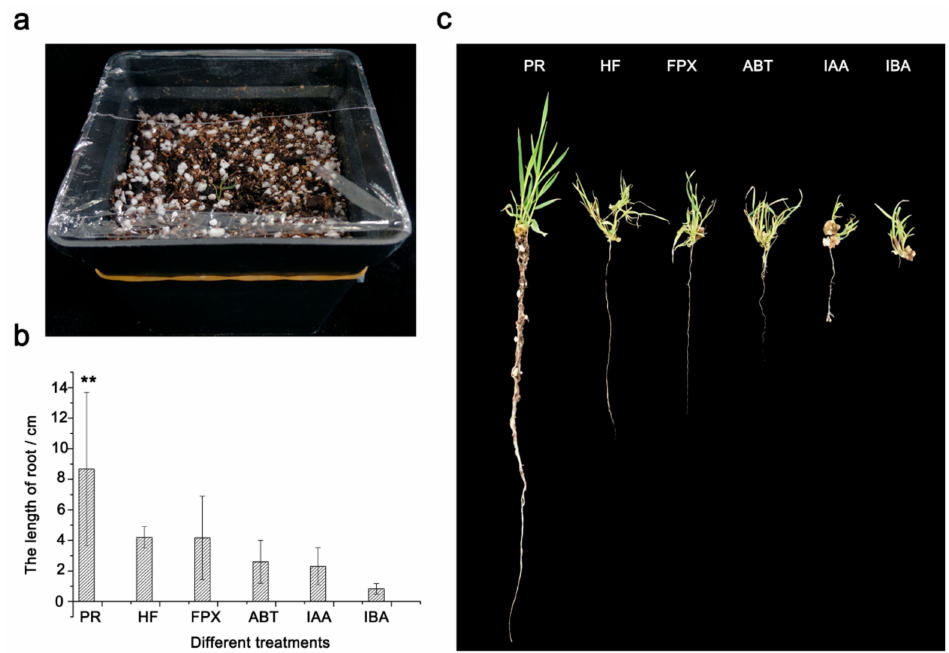
Figure 3. Comparison of the rooting e ffi ciency between PR and RIM-based methods. ( a ). A photograph demonstrating the performance of photoautotrophic rooting. ( b ). The length of regenerated roots cultured on di ff erent methods. Root lengths were measured and compared with each other after two weeks of culturing. ( c ). Photos of adventitious roots from di ff erent rooting methods. PR, photoautotrophic rooting. HF, hormone-free RIM. ABT, ABT-2 rooting powder (20% NAA and 30% IAA). IAA, 3-Indole acetic acid. IBA, Indole-4-butyric acid. For each treatment, three replicates were conducted. Error bars represent ± SE, n = 20. Asterisk indicates significant di ff erence relative to HF (Student’s t test, * p < 0.05 and ** p <